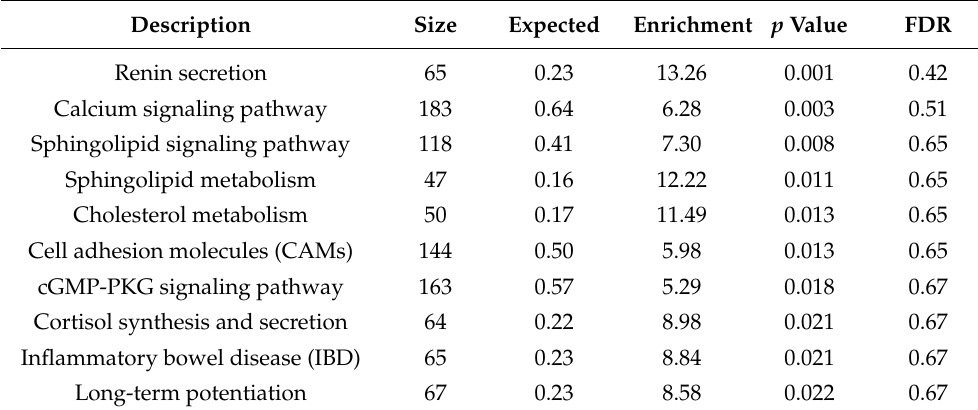
Table 3. Over-representation analysis of the genes selected by the ML model.